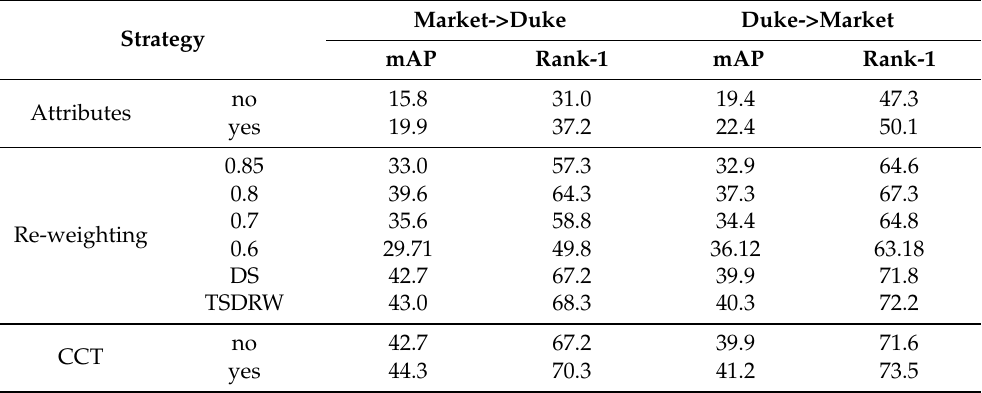
Table 1. Ablation Experiments. In re-weighting, TSDRW and DS denote temporal smoothing dynamic re-weighting and dynamic sampling, while the other denotes fixed-threshold sampling. The CCT denotes whether we were using the cross-camera triplet